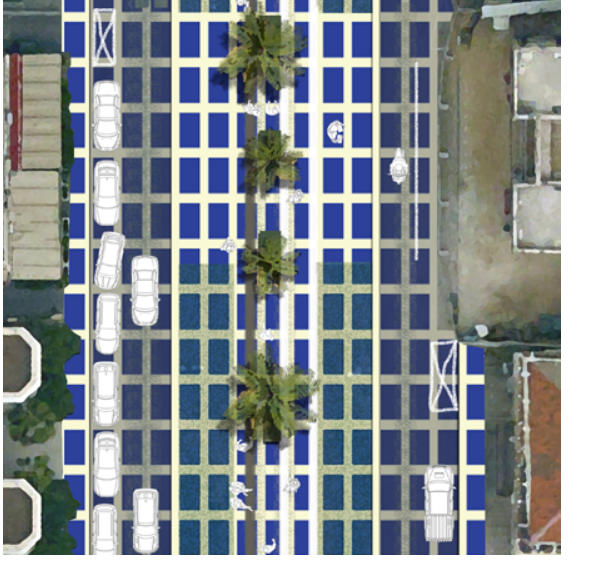
Imaginary scene of the intervention during its daily FIG. 6 Top view of the intervention, detail [credits: the use [credits: the